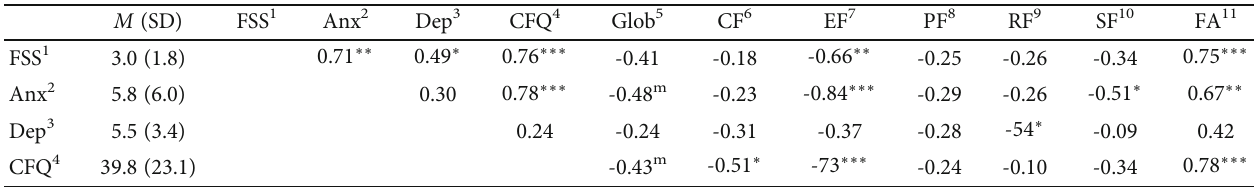
(a) Descriptive statistics and correlations between main variables at baseline ( T 0 )